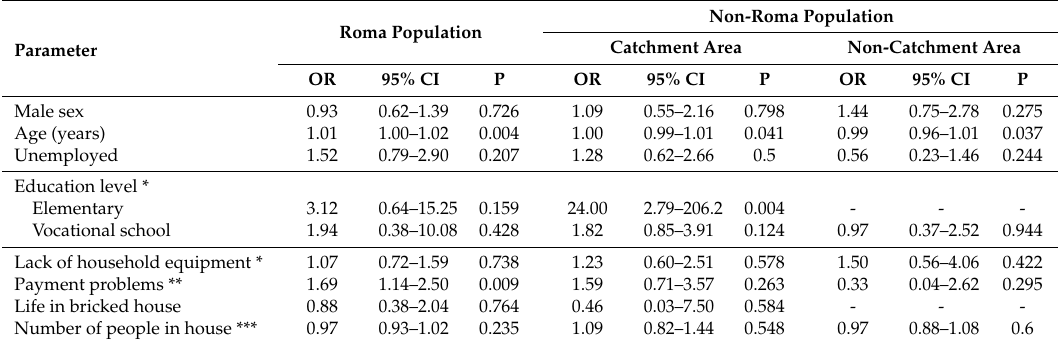
Table 3. Risk factors of seropositivity to Toxoplasma gondii for Roma a non-Roma population. Roma Population Parameter Male sex